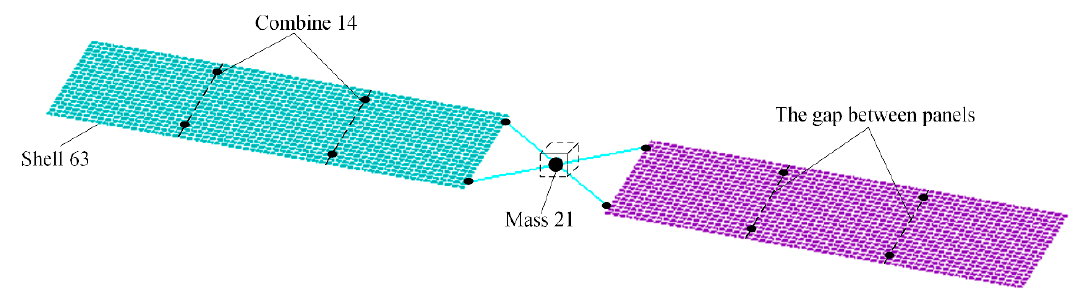
Figure 4. Finite element model of the LSFS in ANSYS.